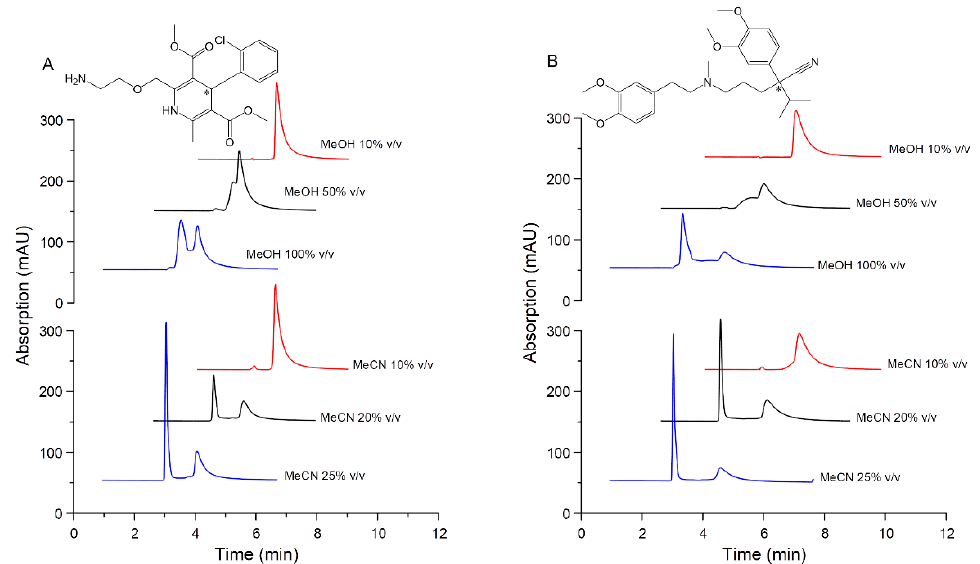
Figure 2. Influence of methanol (MeOH) and acetonitrile (MeCN) as organic solvents in various concentrations of sample diluent towards enantioseparation profiles of ( A ) amlodipine, AML and ( B ) verapamil, VER, as racemic mixtures. Stationary phase: CSA column; mobile phase: 50 mM phosphate buffer pH 3.5; flow rate 0.8 mL/min; UV detection ( A ) 240 nm and ( B ) 230 nm. The organic solvent was prepared in water (aqueous solution).